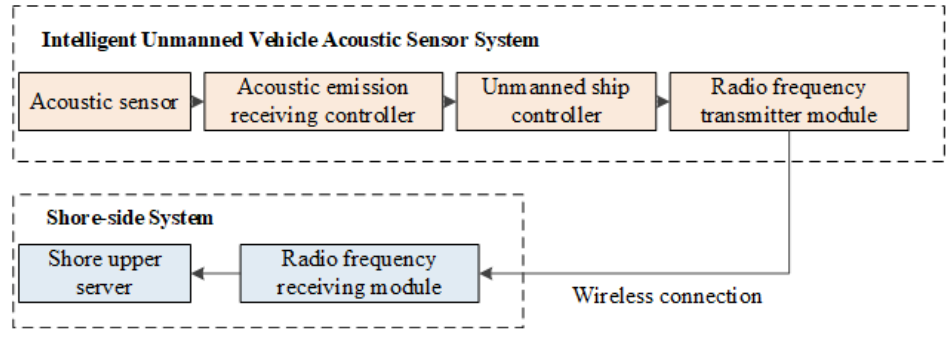
Figure 7. Framework of experimental platform.